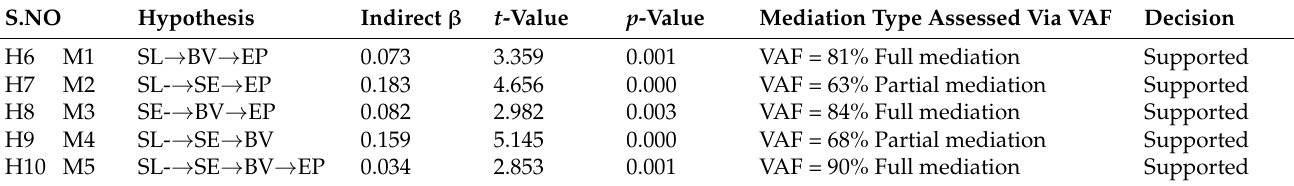
Table 7. Hypothesis testing (Test of Indirect Effects/Mediation).